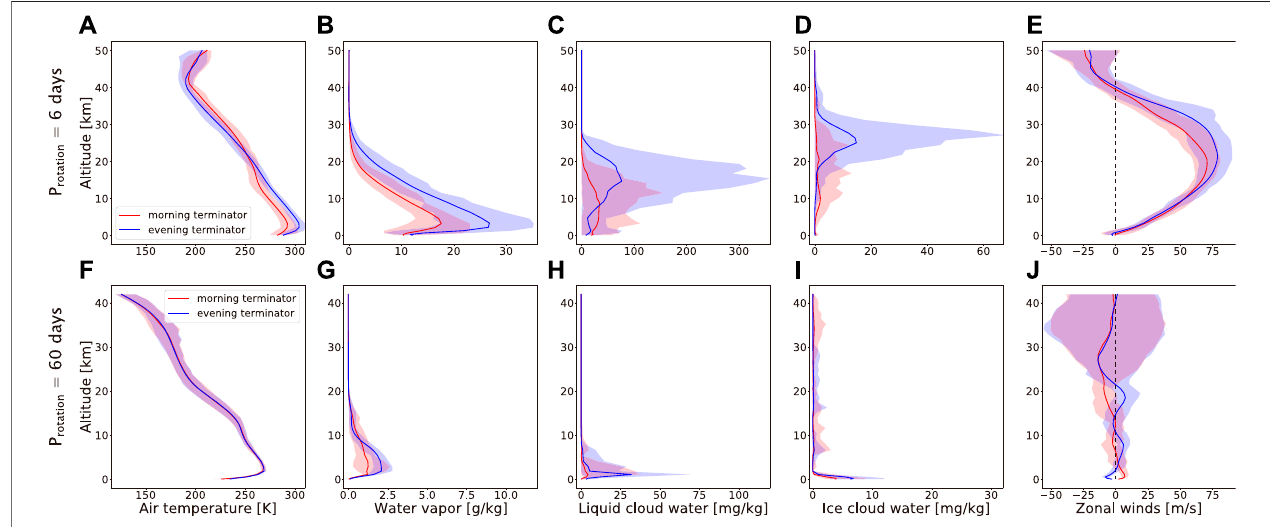
FIGURE 3 | Asymmetry and variability in climatic variables. Pro fi les of air temperature (A, F) , water vapor concentration (B, G) , liquid cloud water (C, H) , ice cloud water (D, I) , and zonal (west-to-east) winds (E, J) at theterminators. Red color isfor the morning terminator and blue coloris for theevening terminator. Lines are for the